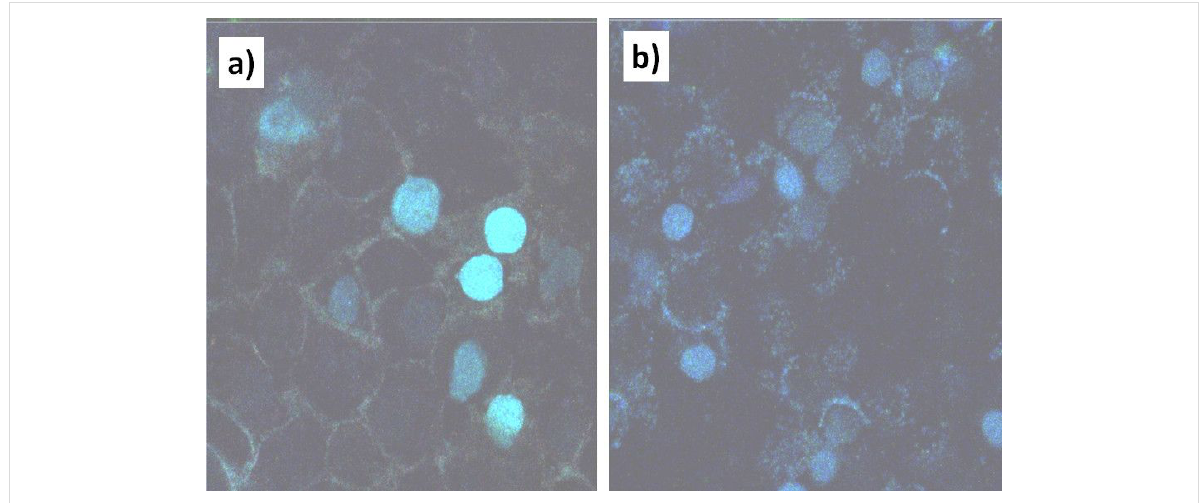
Figure 9: Fluorescent images recorded for human normal prostate epithelium cellular line (PNT1A) (a) and human prostate cancer cellular line (DU145) (b) with uptake of P(AA- co -FA)-functionalized BNNTs. Excitation wavelength: 490 nm; emission wavelength: 520 nm.